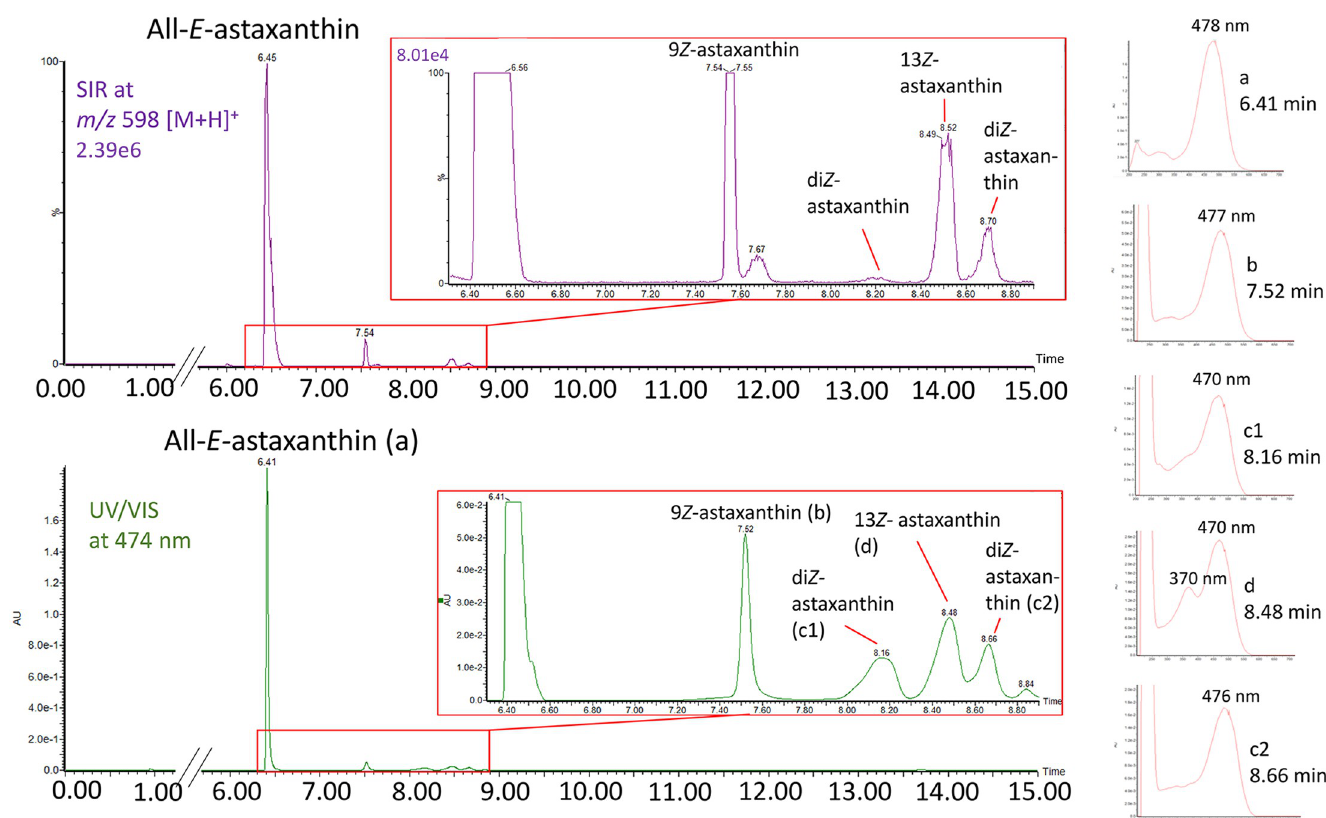
Fig 3. UV/Vis and SIR chromatograms of an enzymolyzed H . pluvialis extract and corresponding absorption spectra of astaxanthin diastereomers.